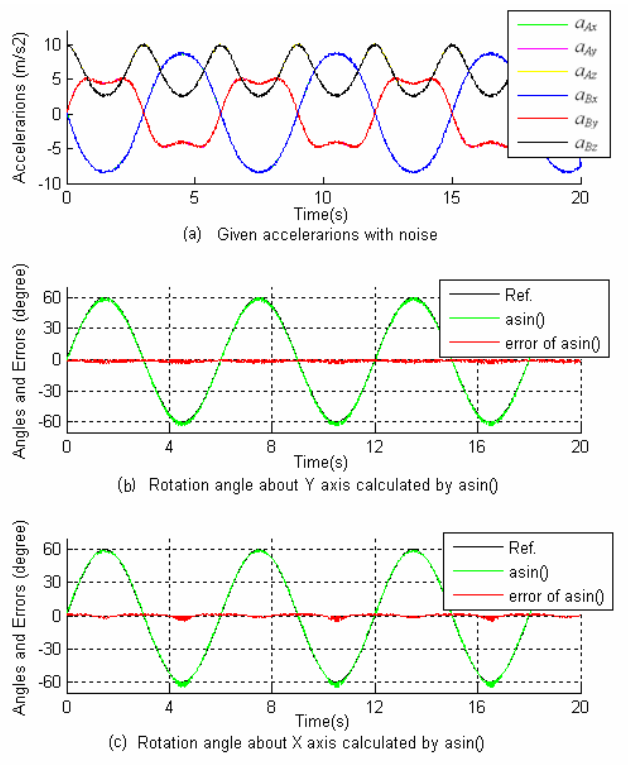
Fig.7 Given accelerations and the corresponding angle of θ y , θ x with noises Then, simulation for evaluating the double-sensor difference based algorithm for lower limb orientation analysis in 3D frame was done. As Eqs.(15) ~ (18) show, angular displacements in two directions can be obtained on the basis of a series of accelerations. In the simulation, a , a , a , a , a , a were given signals, r Ax Ay Az Bx By Bz